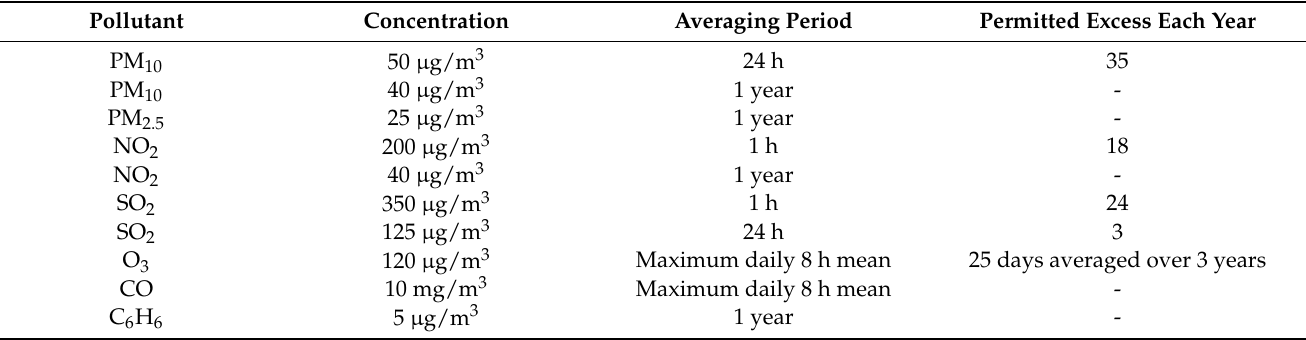
Table 3. Directive 2008/50/EC standards of the main